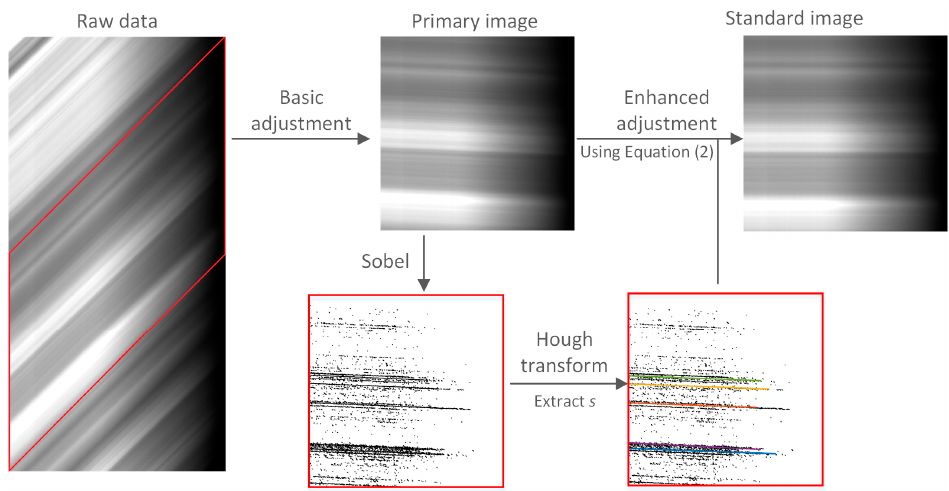
Figure 6. The side-slither data standardization based on the linear features.